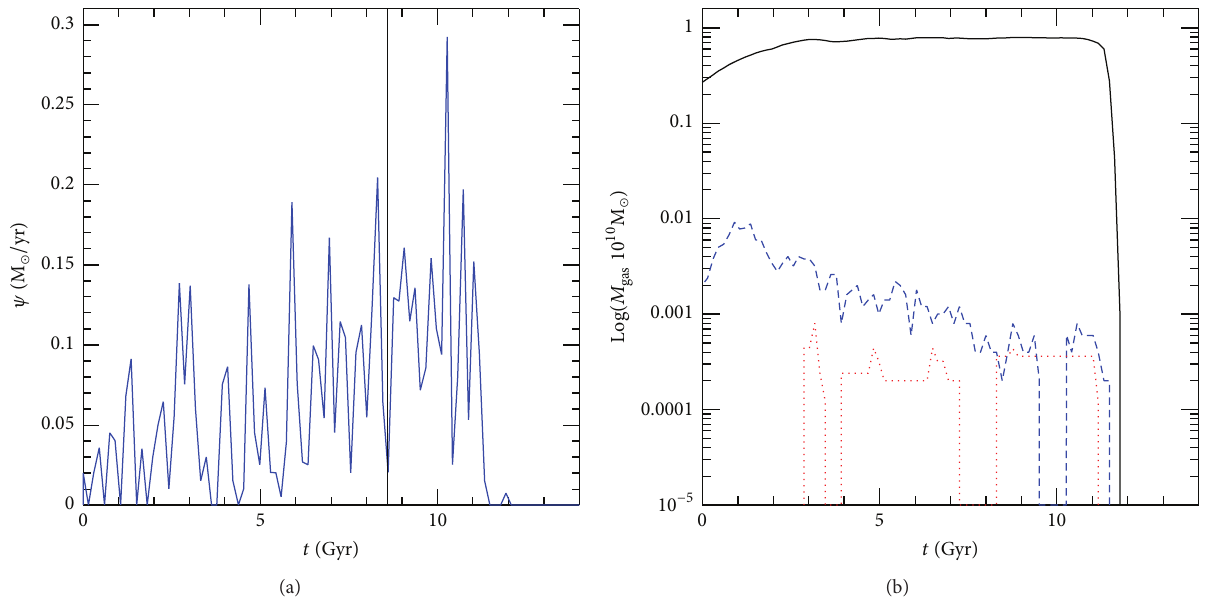
Figure 6: (a) The evolution of the SFR predicted by our simulation for UGC 7639. The black vertical line corresponds to the galaxy age (8.6 Gyr; see text). (b) Gas accretion history (solid line), that is, the evolution of the gas mass inside a radius of 50 kpc on the r-band image luminous center of the galaxy from our selected SPH simulations. The (blue) dashed and the (red) dotted lines correspond to the gas with temperatures 10 4 K and 10 6 K,